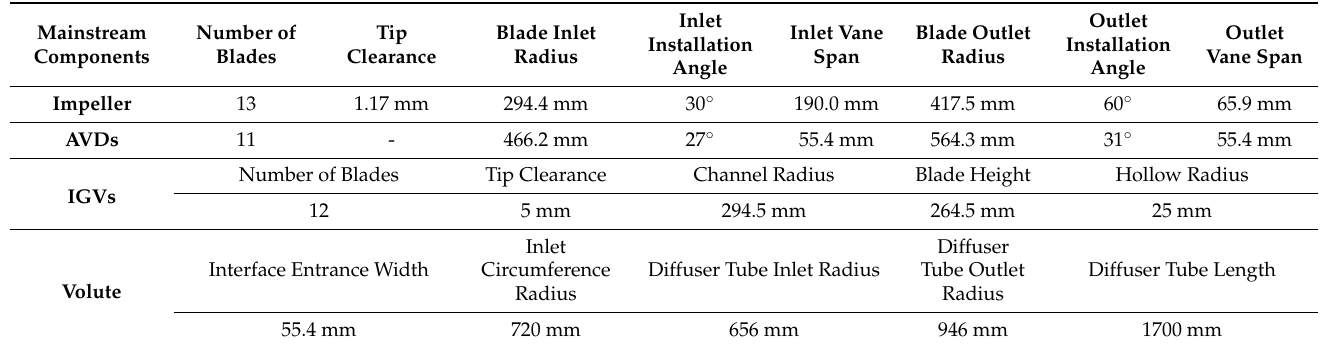
Table 1. Main structural parameters of mainstream